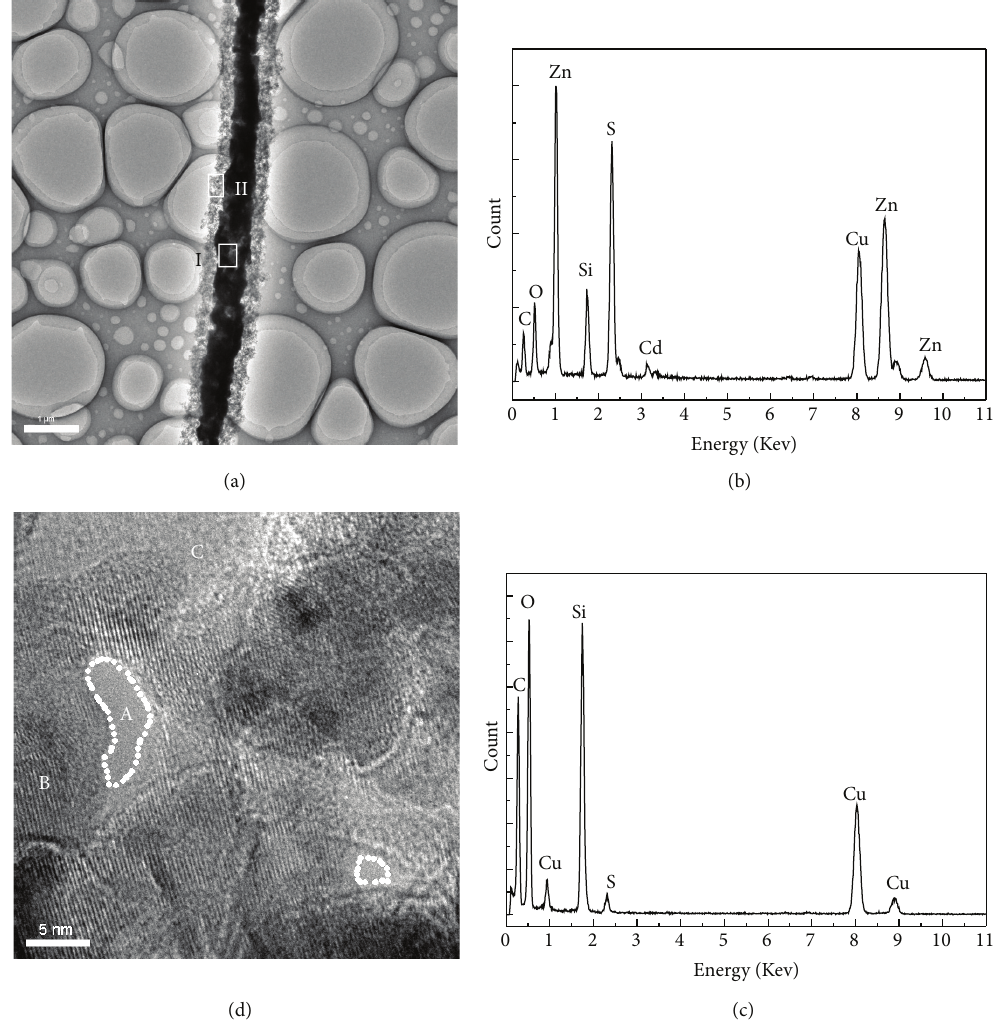
Figure 2: TEM results of the as-synthesized 1D nanostructure: (a) typical TEM image of a single 1D wire-like nanostructure; (b) and (c) EDS spectra taken from the inner as indicated in square I and the outer as indicated in square II of the nanostructure, respectively; and (d) HRTEM image of the